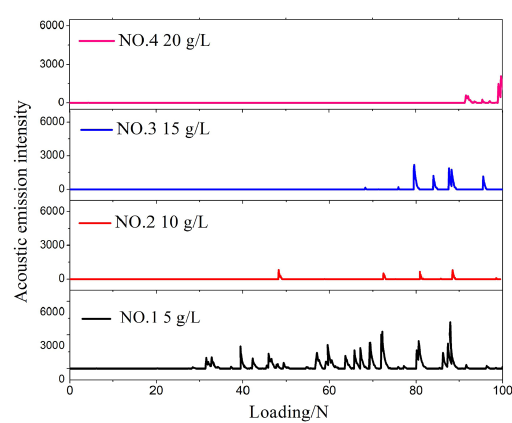
Figure 14. Scratch curves of Ni-W-P